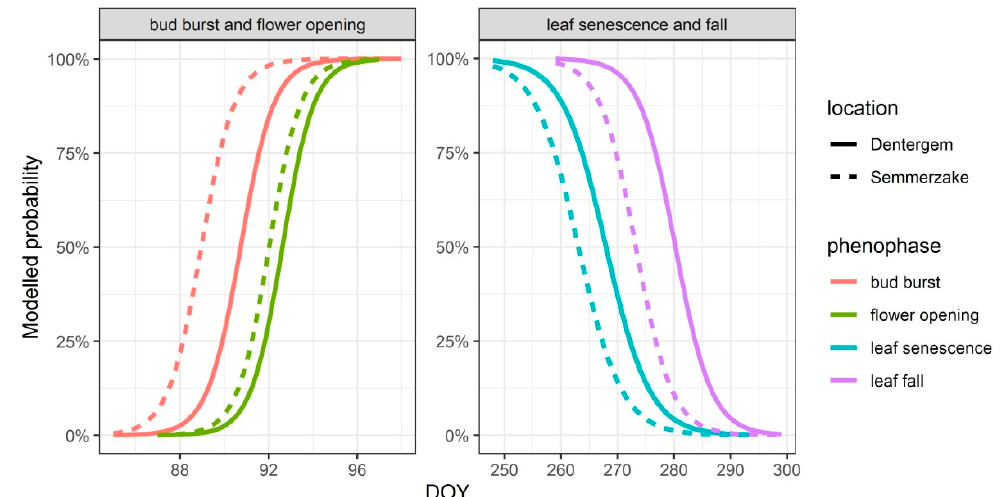
Figure 3. Modelled timing of bud burst, flower opening, leaf senescence and leaf fall at the two common gardens Dentergem and Semmerzake. For bud burst and flower opening, the probability is displayed for having reached a score of 4 or higher. For leaf senescence, the probability is displayed for having reached a score of 2 or lower. For leaf fall, the probability is displayed for having reached a score of 3 or lower.